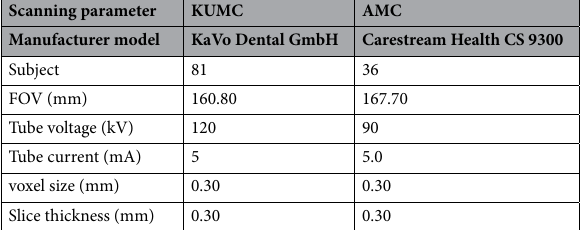
Table 1. Number of data acquired from two centers and scanning parameters (KUMC, Korea University Medical Center; AMC, Asan Medical Center).